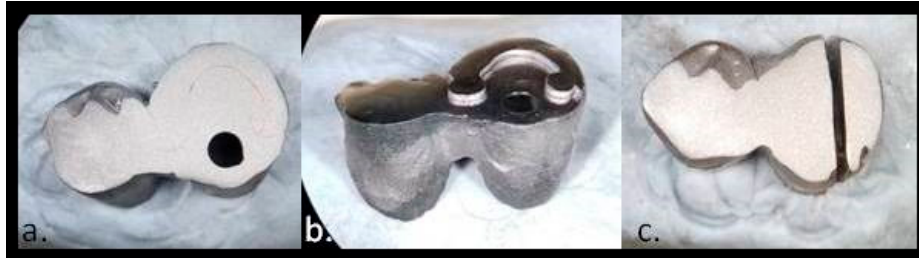
Figure 14. Assembly of prosthetic frameworks made by CoM method. ( a , b ). Detachable prosthetic frameworks; ( c ). Non-detachable prosthetic frameworks.